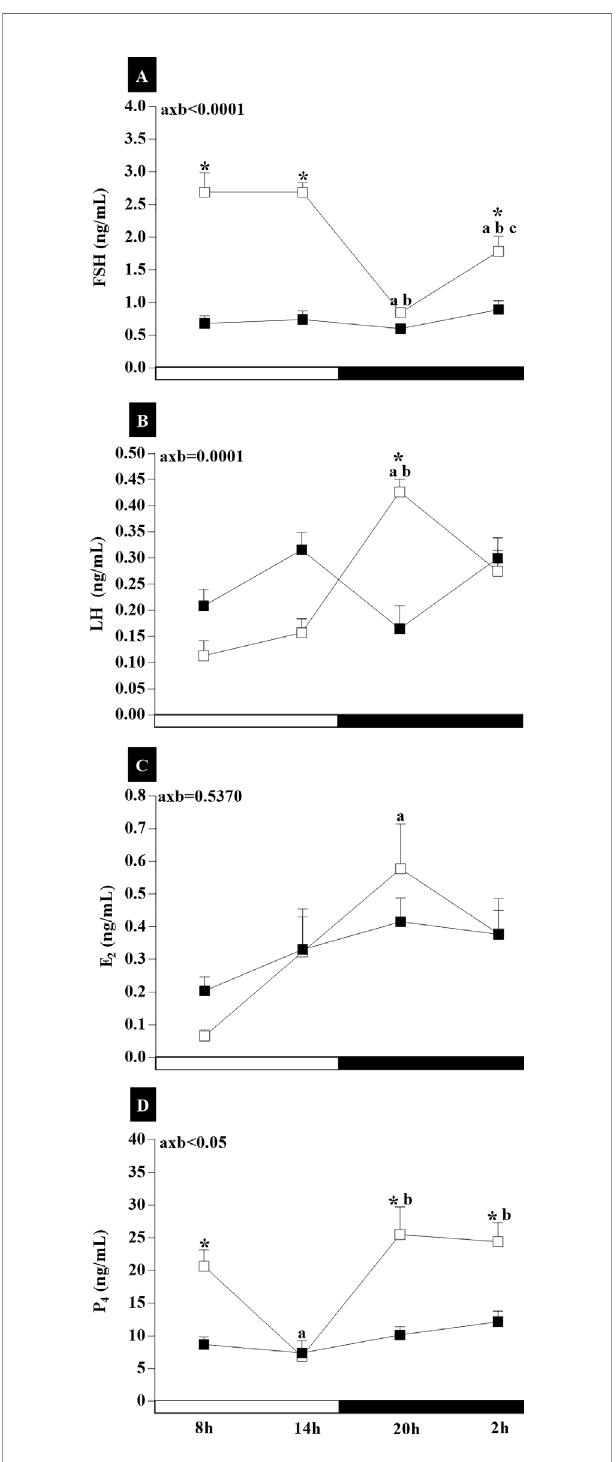
FIGURE 1 | The plasma levels of gonadotropins (A, B) and steroids (C, D) of adult rats with a regular estrous cycle (RC) on diestrus day ( ■ ) and IC group rats with an irregular cycle (IC) in persistent diestrus ( □ ) at 8:00, 14:00, 20:00, and 02:00. The data are expressed as the mean ± SEM. * p < 0.05 vs. RC at the same time; a vs. 08:00, b vs.14:00, and c vs. 20:00; axb = interaction of age and